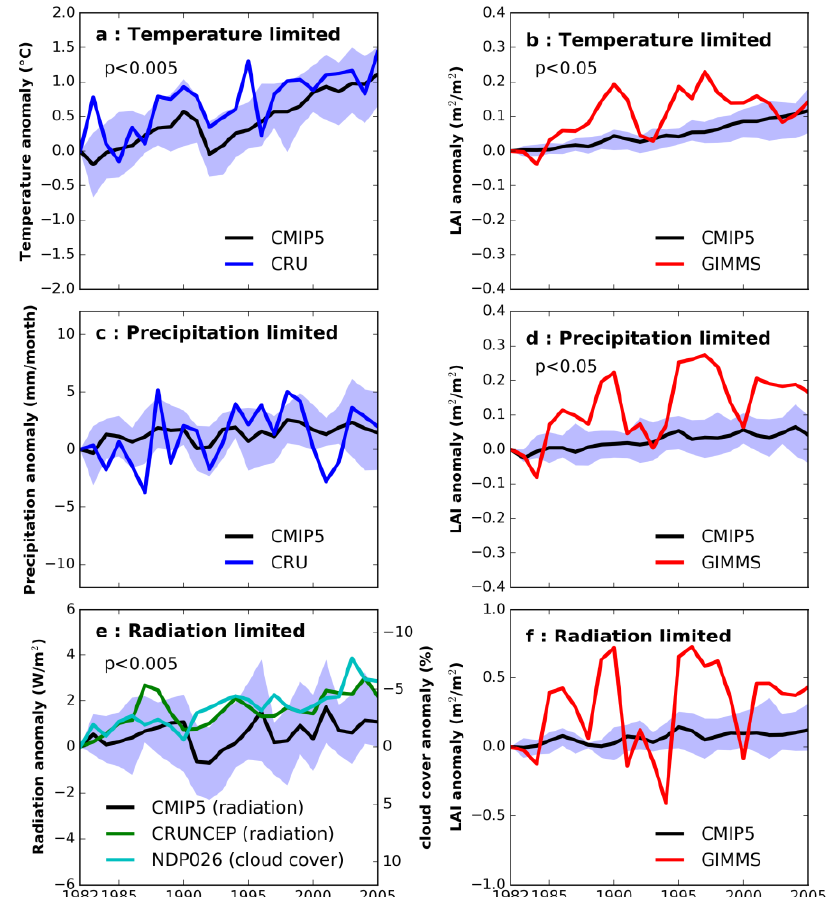
Figure 14. Performance of Earth system models in capturing the observed trends in climate and vegetation. Observed trends in annual mean climate and satellite-derived LAI from 1982 to 2005 are shown as average responses over the three climate-limiting regions. Ensemble mean of CMIP5 models over the same period do not capture the inter-annual variability, but appear to capture the overall trends in climate and vegetation. The first year of each series is set to zero to emphasize the magnitude of the trend and deviation between the trend lines. The p -values indicate the level of significance for the trends in observations only (CRU, CRUNCEP, GIMMS, and cloud cover data from NDP026). Shading around the CMIP5 ensemble mean indicates 25–75 percentile.